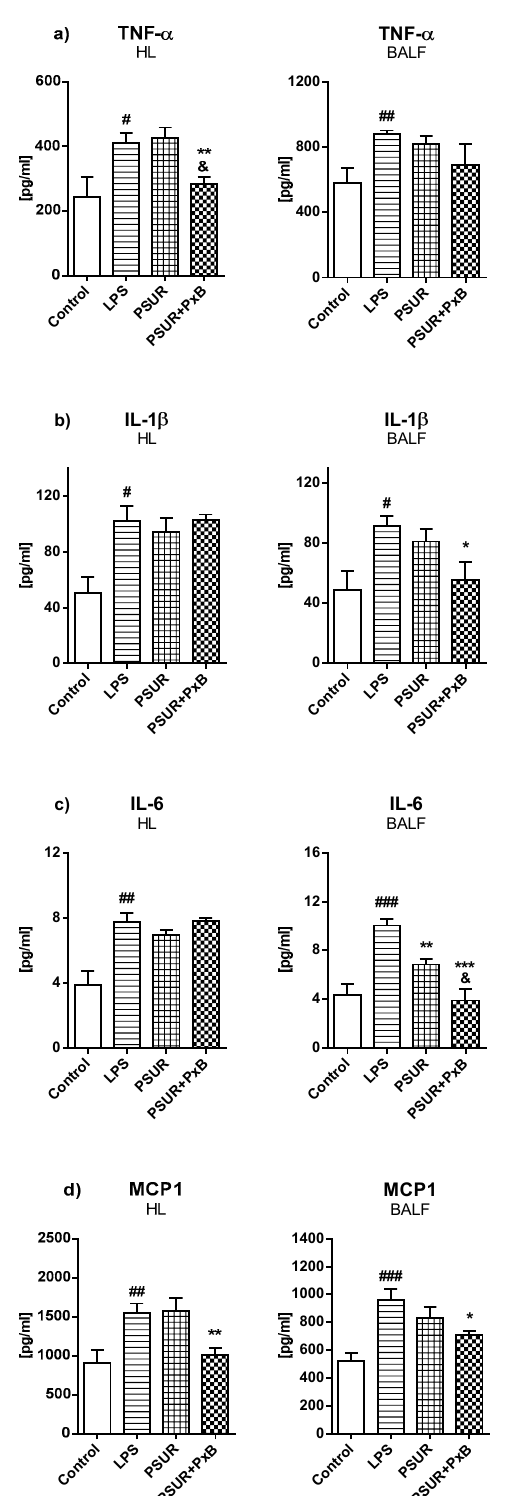
Figure 7. Levels of ( a ) tumor necrosis factor alpha (TNF α ), ( b ) interleukin 1 β (IL-1 β ), ( c ) interleukin 6 (IL-6), and ( d ) monocyte chemotactic protein 1 (MCP1) in homogenized lung (HL) and in bronchoalveolar lavage fluid (BALF). Control vs. LPS # p < 0.05, ## p < 0.01, ### p < 0.001, PSUR vs. LPS, PSUR + PxB vs. LPS * p < 0.05, ** p < 0.01, *** p < 0.001, PSUR vs. PSUR + PxB & p < 0.01.